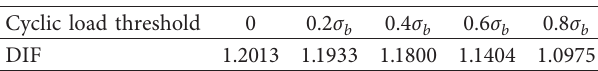
Table 3: DIF of sandstones with different degrees of